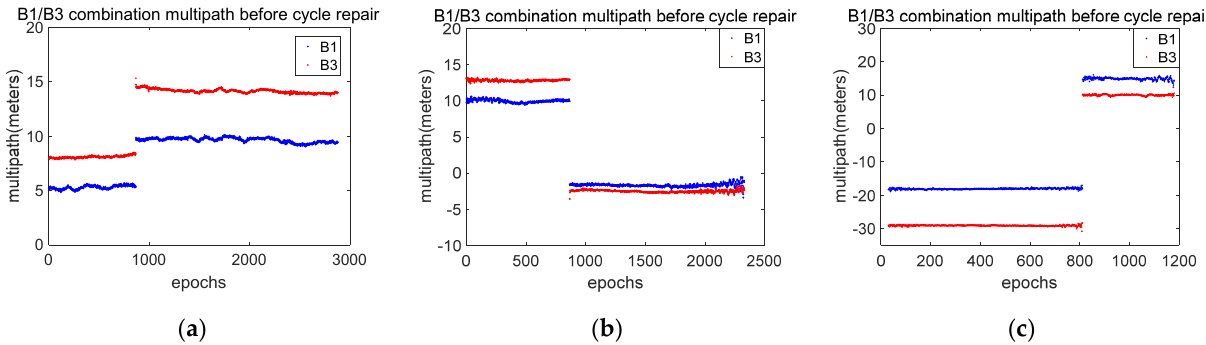
Figure 6. Combined multipath values for the B1 and B3 frequencies before the cycle slips were repaired.